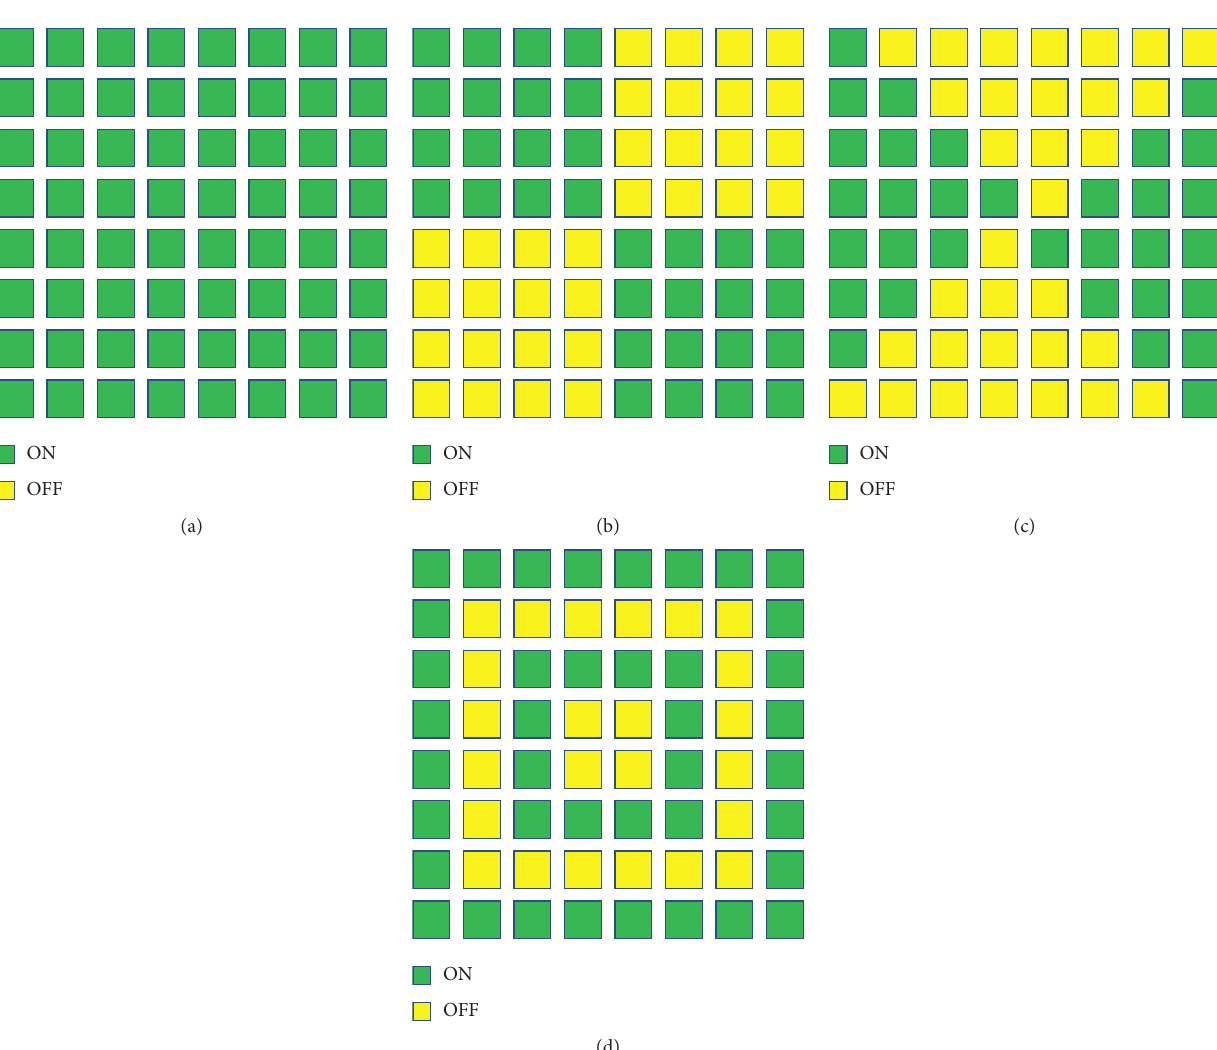
Figure 5: Simple version diagram of different layouts; (a) reference antenna (when all PIN diodes are of “ON” or “OFF” states, here just take all “ON” states as an example); (b) checkerboard layout; (c) new chessboard layout; (d) “0101” square ring nested